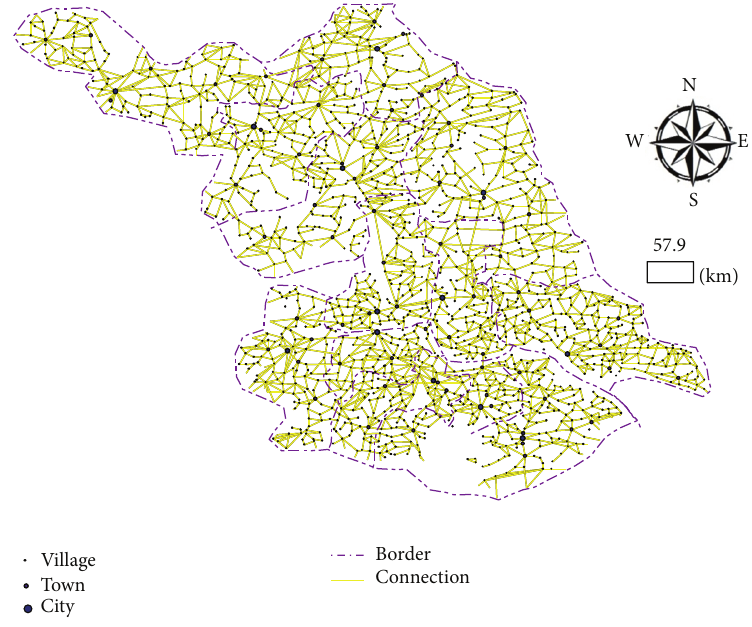
Figure 1: Nodes and connections within Jiangsu province.